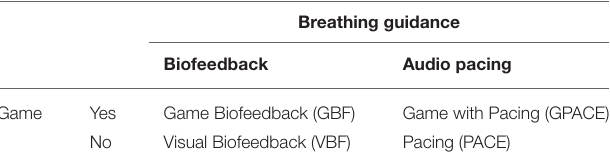
TABLE 1 | Four interventions resulting from a factorial design with game delivery (game vs. no-game) and type of breathing guide (pacing vs. biofeedback) as independent